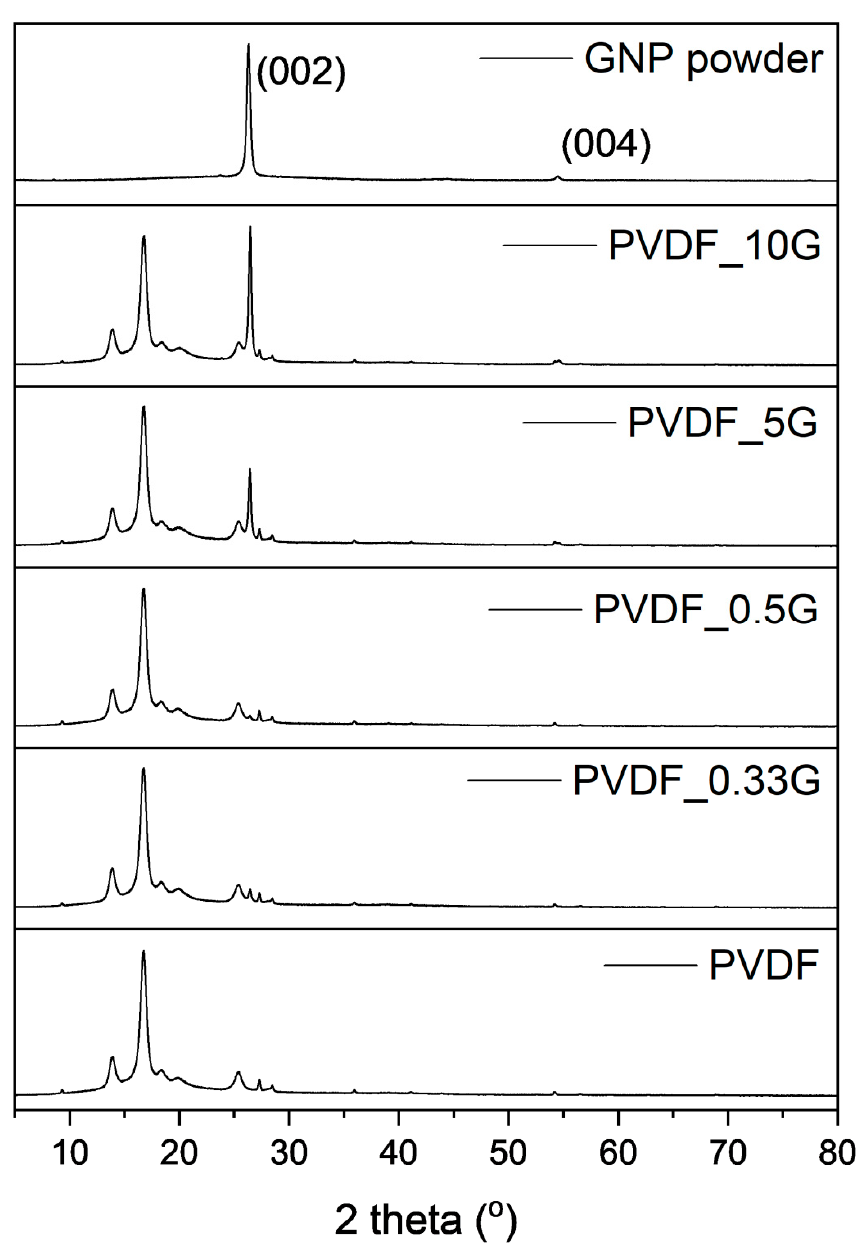
Figure 4. XRD patterns of pristine PVDF membrane and its graphene-based composites.